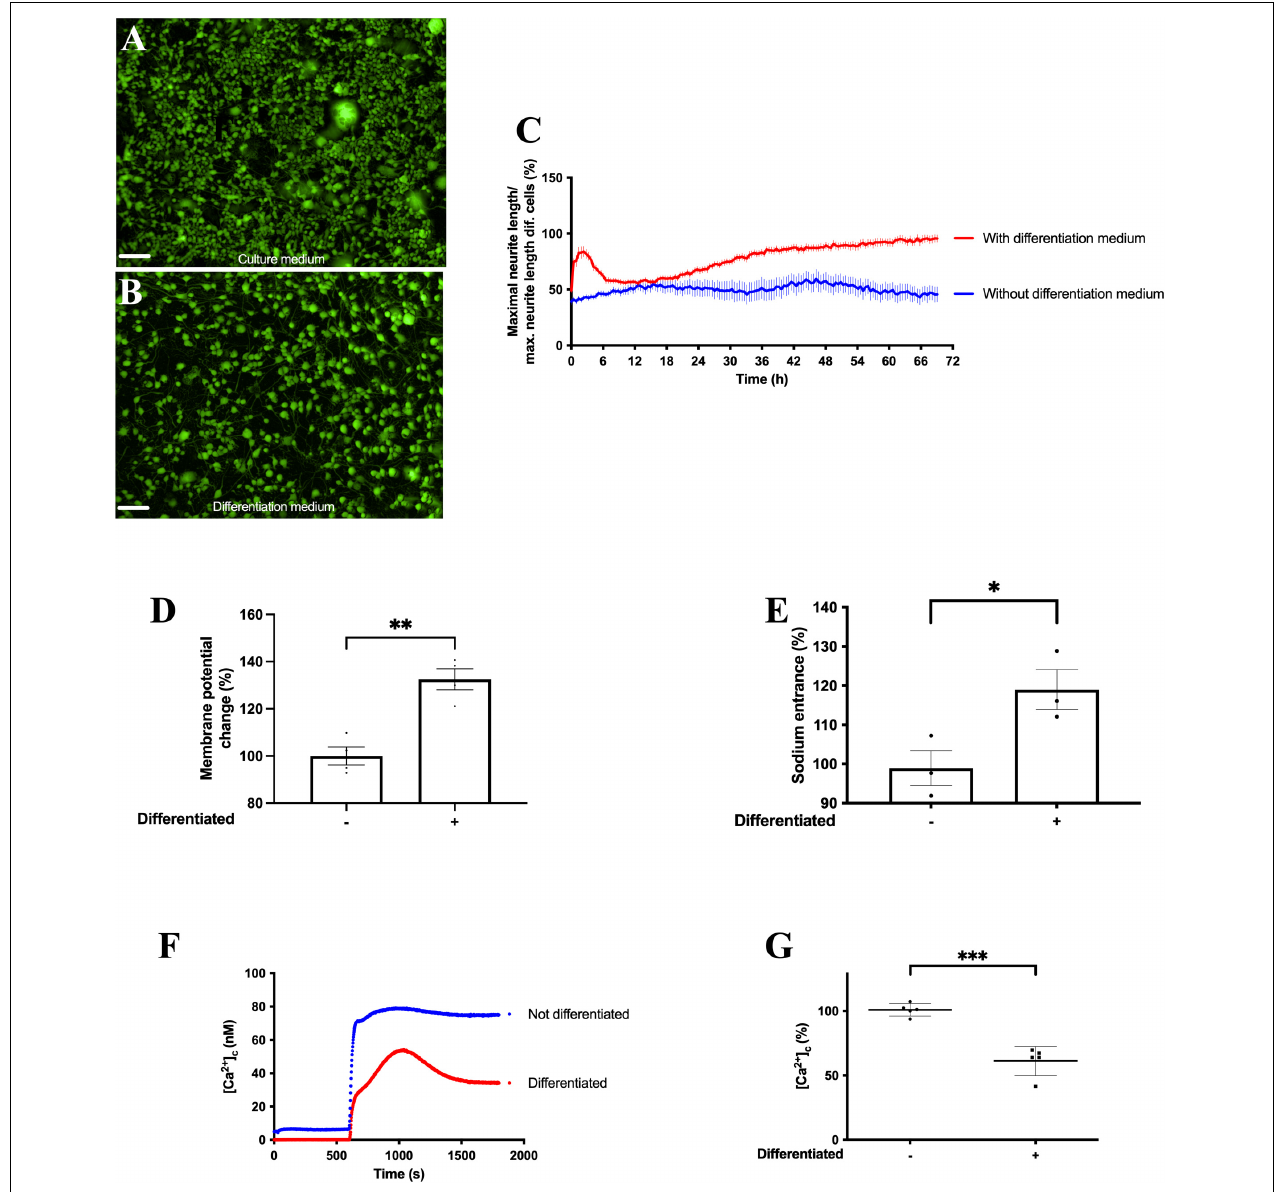
FIGURE 1 | Differentiation of F11 cells induces increased neurite length and enhanced changes in intracellular sodium homeostasis and cell membrane potential. Representative images of F11 cells (A) grown in culture medium and (B) exposed to differentiation medium for 72 h. Images are representative of two assays ( n = 2) with 11 replicates per condition, 10X. Scale bar = 100 µ m. (C) Variations in neurite length after 3 days of exposure to differentiation medium and to culture medium. Values shown for (C) are the means ± SEM of two independent assays ( n = 2) with 11 replicates per measurement. (D) Change in membrane potential measured with FluoVolt elicited by 30 mM KCl before and after differentiation. Values shown are the means ± SD of four independent assays ( n = 4) with three replicates per measurement. ∗∗ p < 0.01 (Student’s t- test). (E) Intracellular sodium concentrations in F11 cells before and after differentiation measured with SBFI. Values shown are the means ± SEM of three independent assays ( n = 3) with four replicates per measurement. ∗ p < 0.05 (Student’s t- test). (F) Calcium transients evoked by calcium restoration after exposure to 1 µ M thapsigargin in non-differentiated and differentiated F11 cells and (G) summary results of responses to calcium restoration 16.6 min after the addition of thapsigargin in non-differentiated and differentiated F11 cells. Values shown for (F) are the means of one representative assay of five independent experiments with 12 replicates per measurement. Values shown for (G) are the means ± SD of five independent assays ( n = 5) with 12 replicates per measurement. ∗∗∗ p < 0.001 (Student’s t-